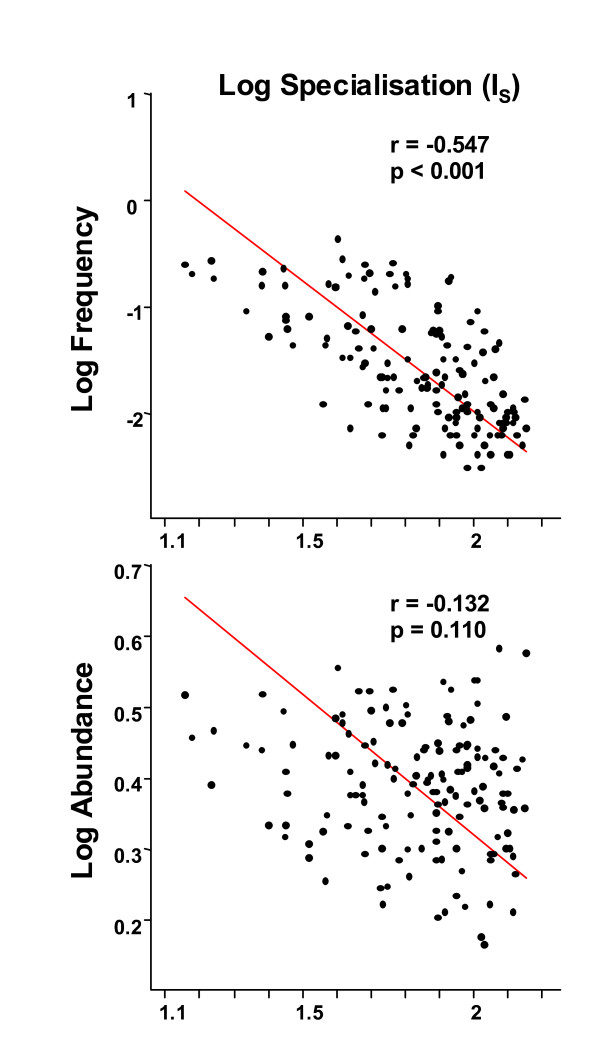
Relationships between weed species specialisation and (a) species frequency and (b) species local abundance. Note: correlations are based on n = 152 plant species.